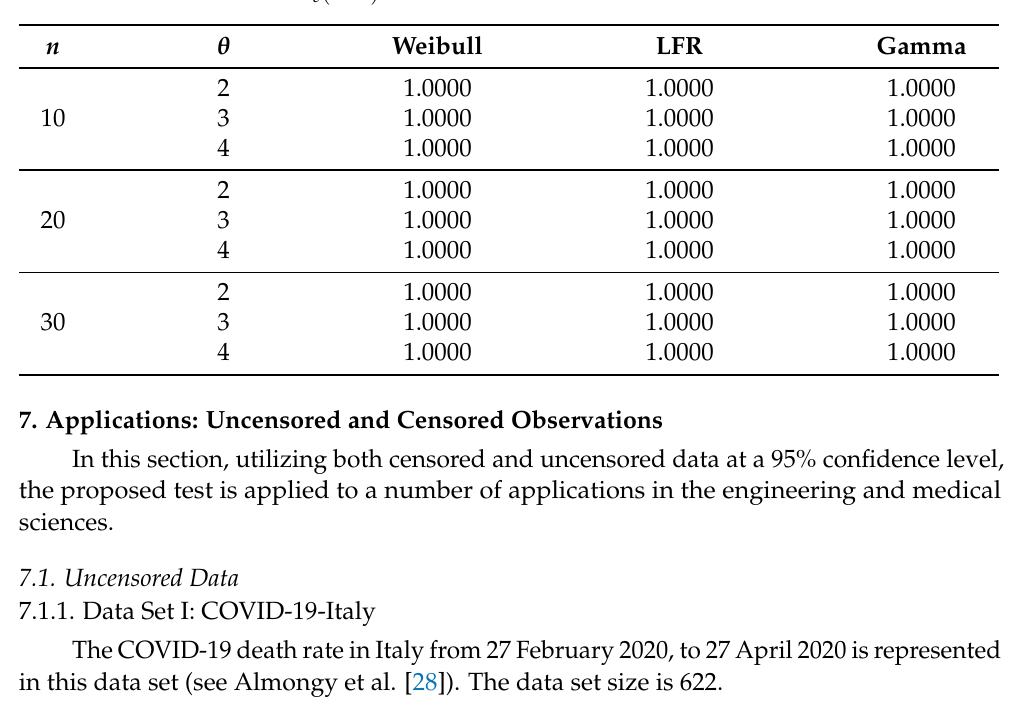
Table 5. Power estimates of ˆ ∆ c ( 0.99 ) .